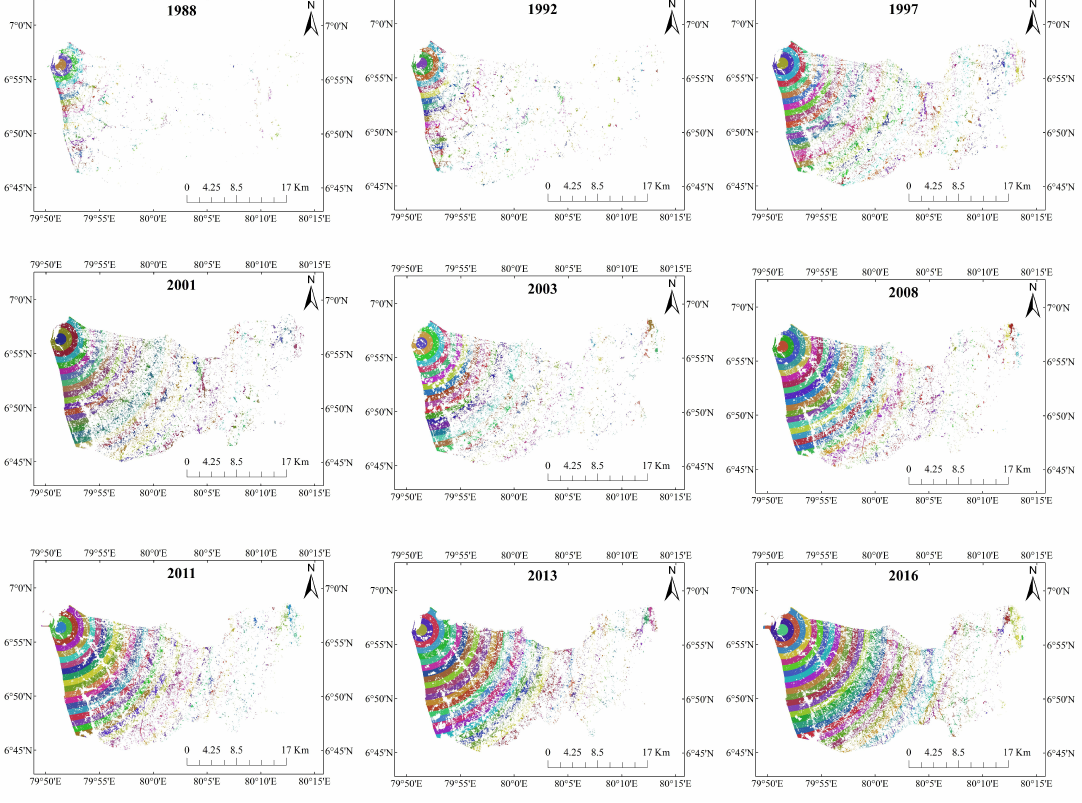
Figure 7. Multi-bu ff er ring analysis of Colombo from 1988 to